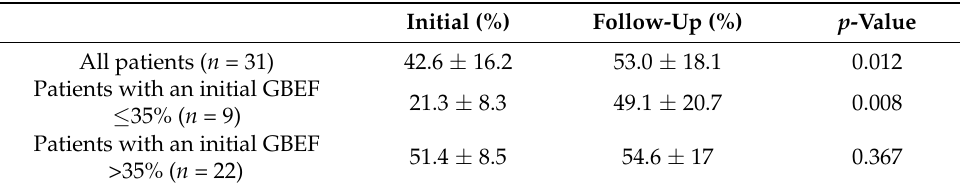
Figure 4. Representative cholescintigraphy of a patient with improved GBEF. ( A ) On initial cholescintigraphy, and ( B ) follow-up cholescintigraphy, GBEF was measured as 21.1% and 61.4%, respectively. GBEF, gallbladder ejection fraction. Table 3. Comparison of the GBEFs at the initial and follow-up (after Rowachol treatment) measurements.